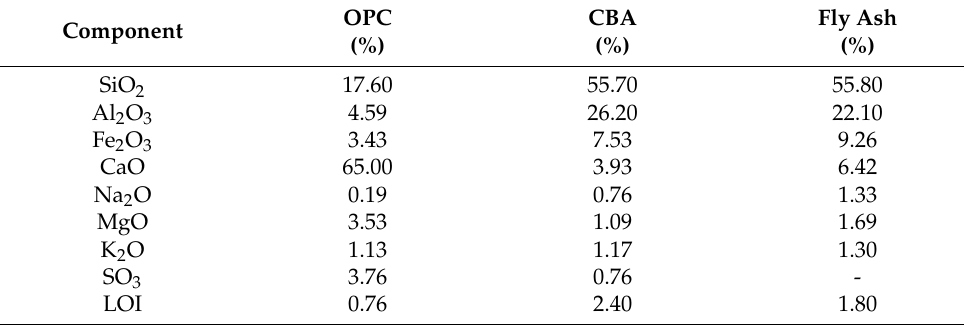
Table 2. Chemical compositions of OPC, CBA, and fly